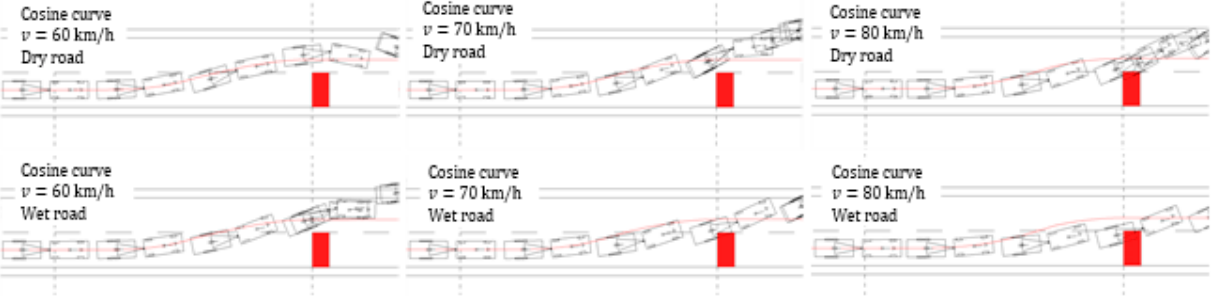
Figure 15. Comparison of animations of the CT unit’s motion on dry and wet road surface for 𝑣 = 60 km/h, 70 km/h and 80 km/h; trajectory calculation method with a cosine curve.